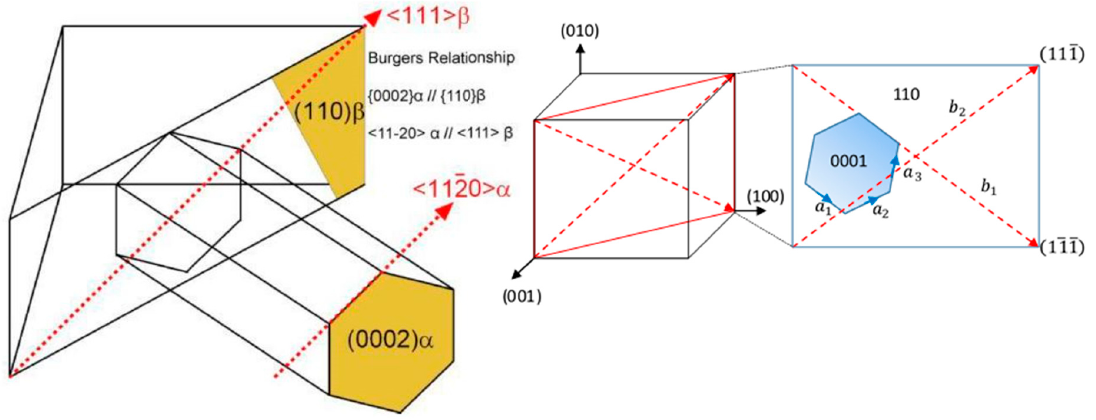
Figure 1. Schematic illustration of the BOR between the β (bcc) and α (hcp) phases in Ti6Al4V [14].